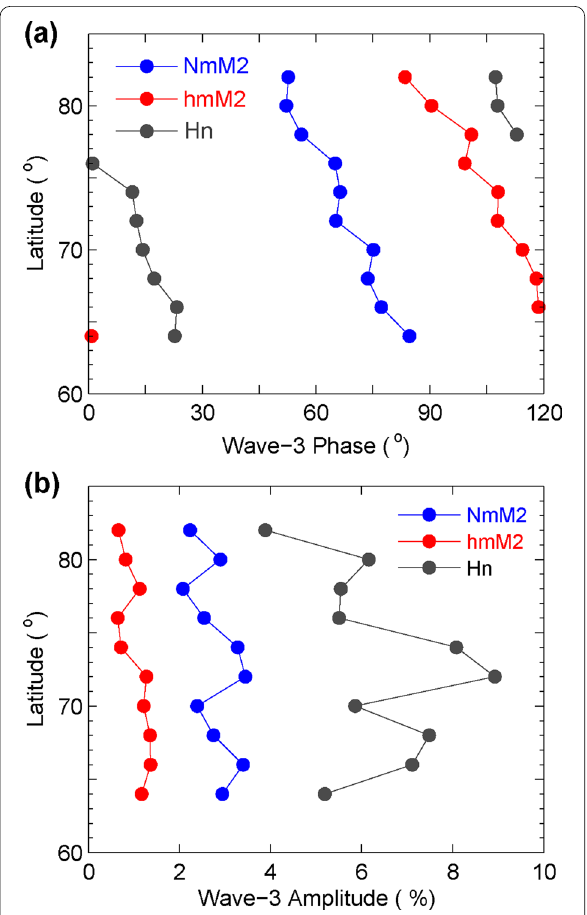
Fig. 6 Latitude variations of a the wave percentage amplitudes. The blue, red, and gray lines are for N m M 2 , h m M 2 , and H n ,